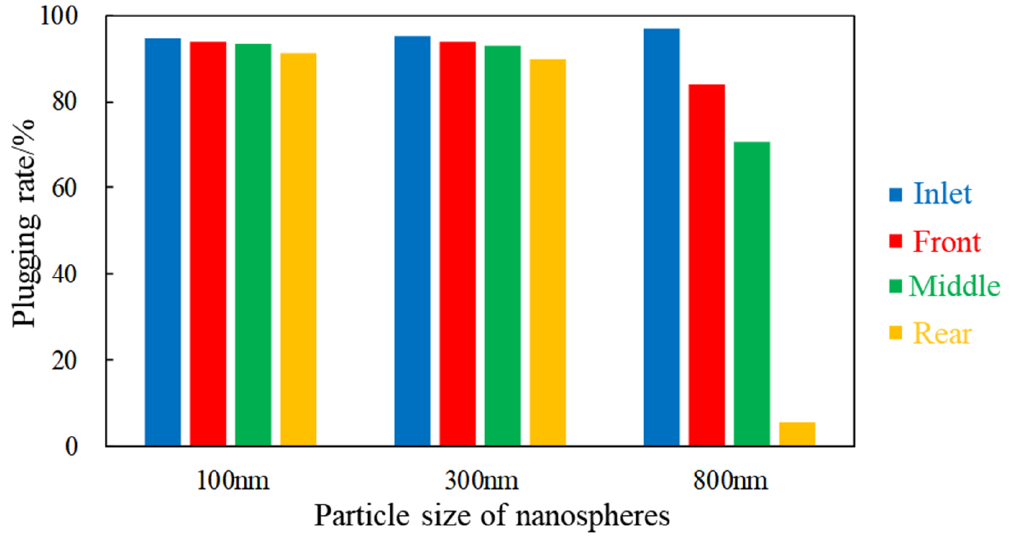
Figure 5. Plugging rate of nanospheres with different sizes at different sections.